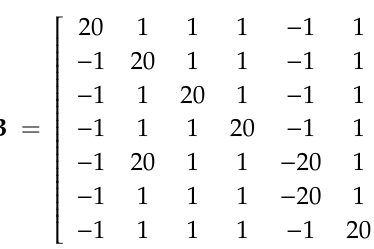
=0.5 =0.5 w w ， and Thre s = 0.001. scl m